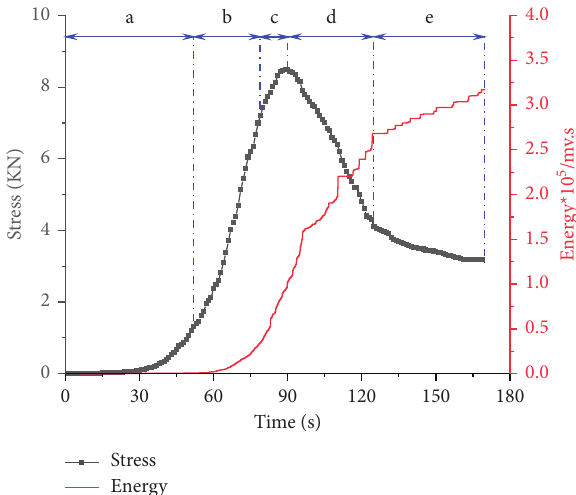
Figure 8: Stress-time curve and AE energy-time curve of under uniaxial compression.